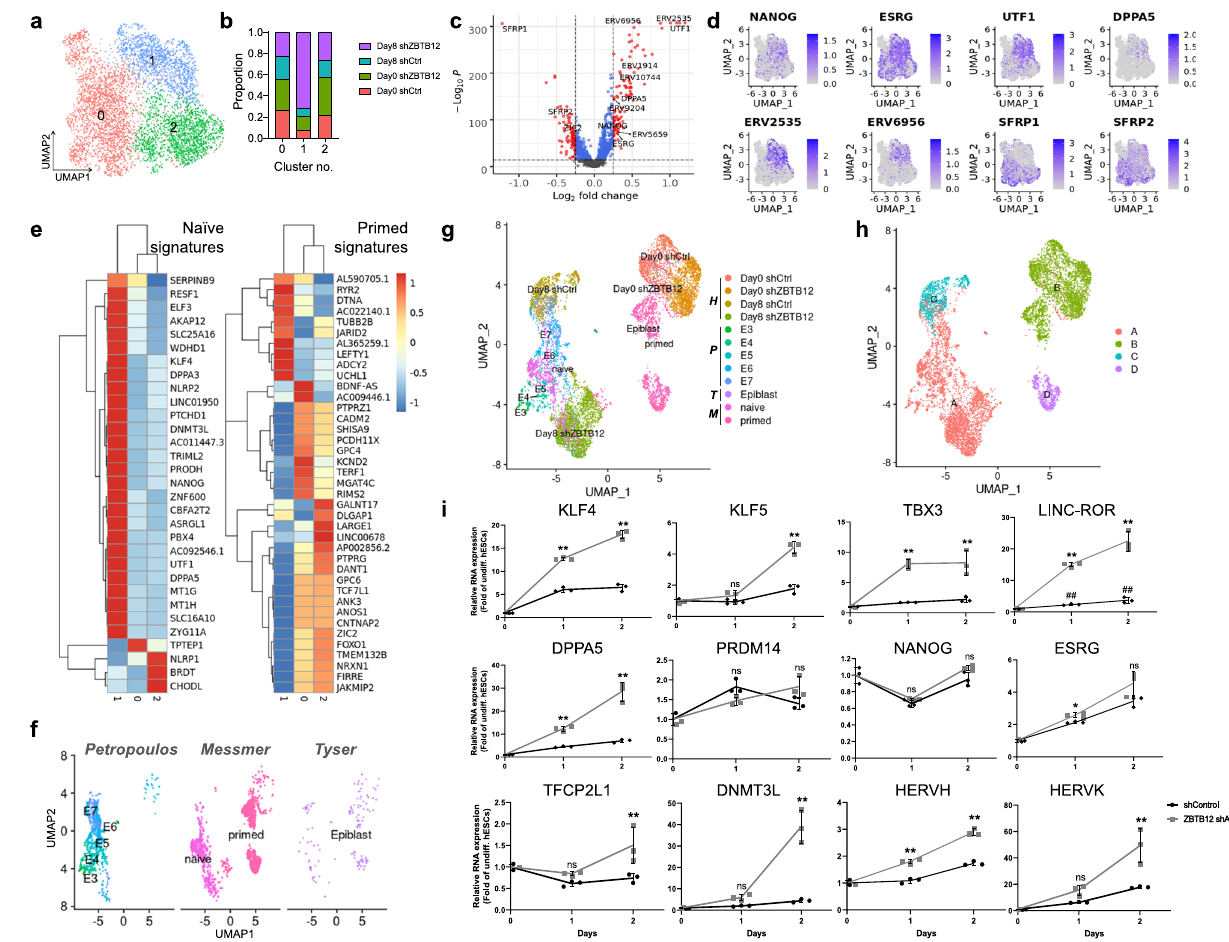
Fig. 3 | ZBTB12 suppression drives hESCs toward a naïve-like state upon dif- ferentiation. a Reconstructed UMAP of pluripotent stem cell clusters 0, 1, and 2 from Fig. 2. b Cellular compositions of each cluster. c Volcano plot showing differentially expressed genes (DEGs, red dots) in cluster 1 (compared to cluster 0 and 2). MAST algorithm is used to statistically determine DEGs, with Benjamini – Hochberg-corrected p values<0.05. Red dots indicate differentially expressed genes(ortranscripts)withcutoff valuesforDEGs: − log 10 P >15;log 2 fold change< − 0.25 or >0.25. Full list of DEGs can be found in Supplementary Data 3. d Expression of representative DEGs associated with naïve-state (NANOG, ESRG, UTF1, and DPPA5), ERVs (ERV2535 and ERV6956), and Wnt antagonists (SFRP1 and SFRP2) on UMAP. e Expression of naïve and primed signature genes 44 in each